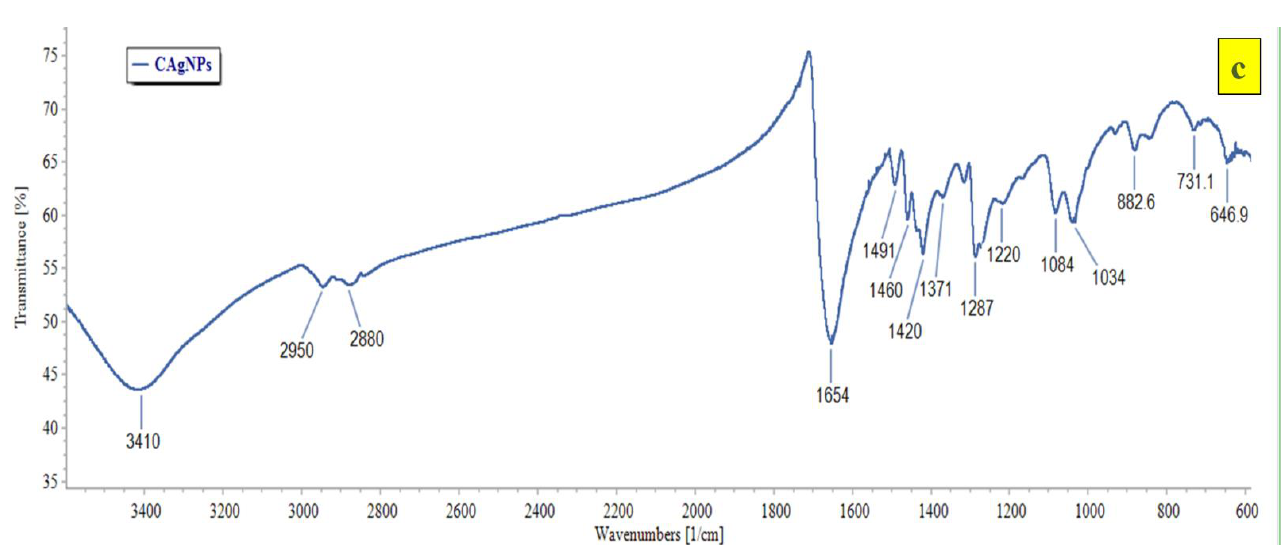
Figure 3. FTIR profile of ( a ) aqueous root extract of G. glabra (RE), ( b ) silver nanoparticles synthesized using aqueous root extract of G. glabra (GRAgNPs) and ( c ) commercial silver nanoparticles (CAgNPs) depicting spectral bands at various positions.